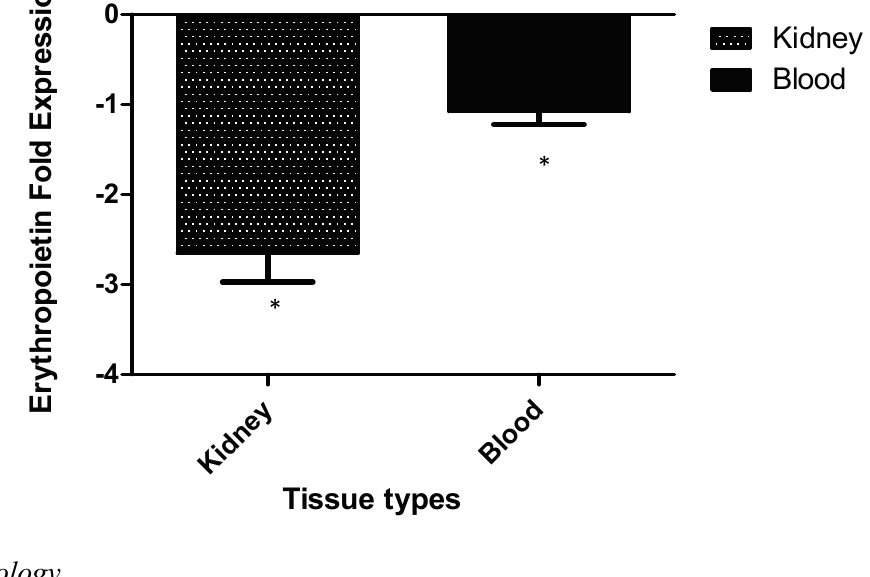
Figure 3. Temporal expression of erythropoietin mRNAs from blood and kidney of C.albicans -infected mice at 72 h post-infection. Transcript levels for erythropoietin were quantified by real-time reverse transcription polymerase chain reaction (RT-PCR). Bar graph represents average expression of each gene normalized to the reference genes, β -actin and Glyceraldehyde 3-phosphate dehydrogenase (GAPDH), to attain a normalized gene expression ratio. Results were means of three biological replicates and two technical replicates for each biological replicate. Bars indicate standard error of mean and * revealed significant differences at the level of p < 0.05 as compared with control group, respectively. The fold changes were calculated based on the normalization of the target gene with the average of housekeeping genes (Beta actin and GAPDH) using the ΔΔ C method in infected mice as compared to that in uninfected